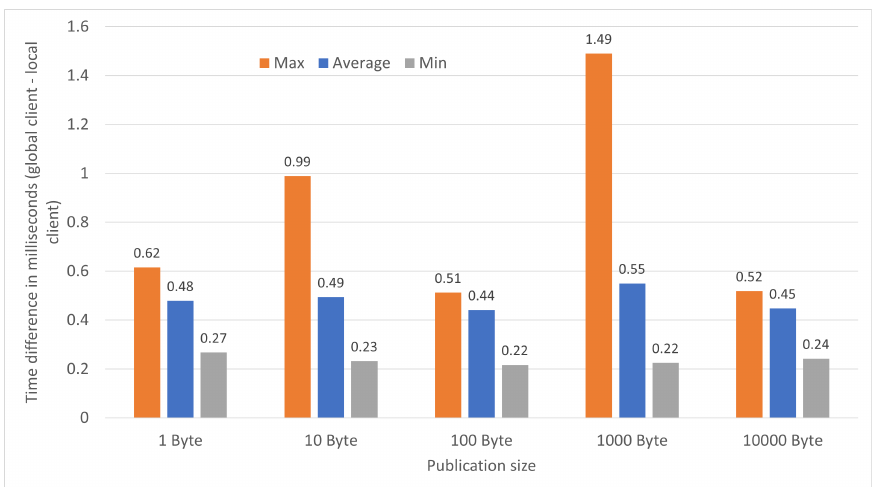
Figure 8. Difference in milliseconds between arrival time for global client and a local client as publication size increases (10 trials